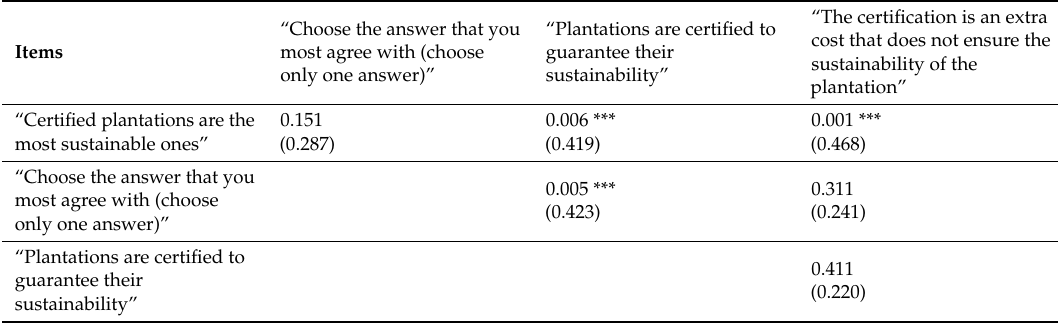
Table 2. Relationship between perceptions of forest certification and sustainability. Figures indicate p -values of Pearson’s chi-squared tests. Figures in brackets indicate Cramér’s V values .